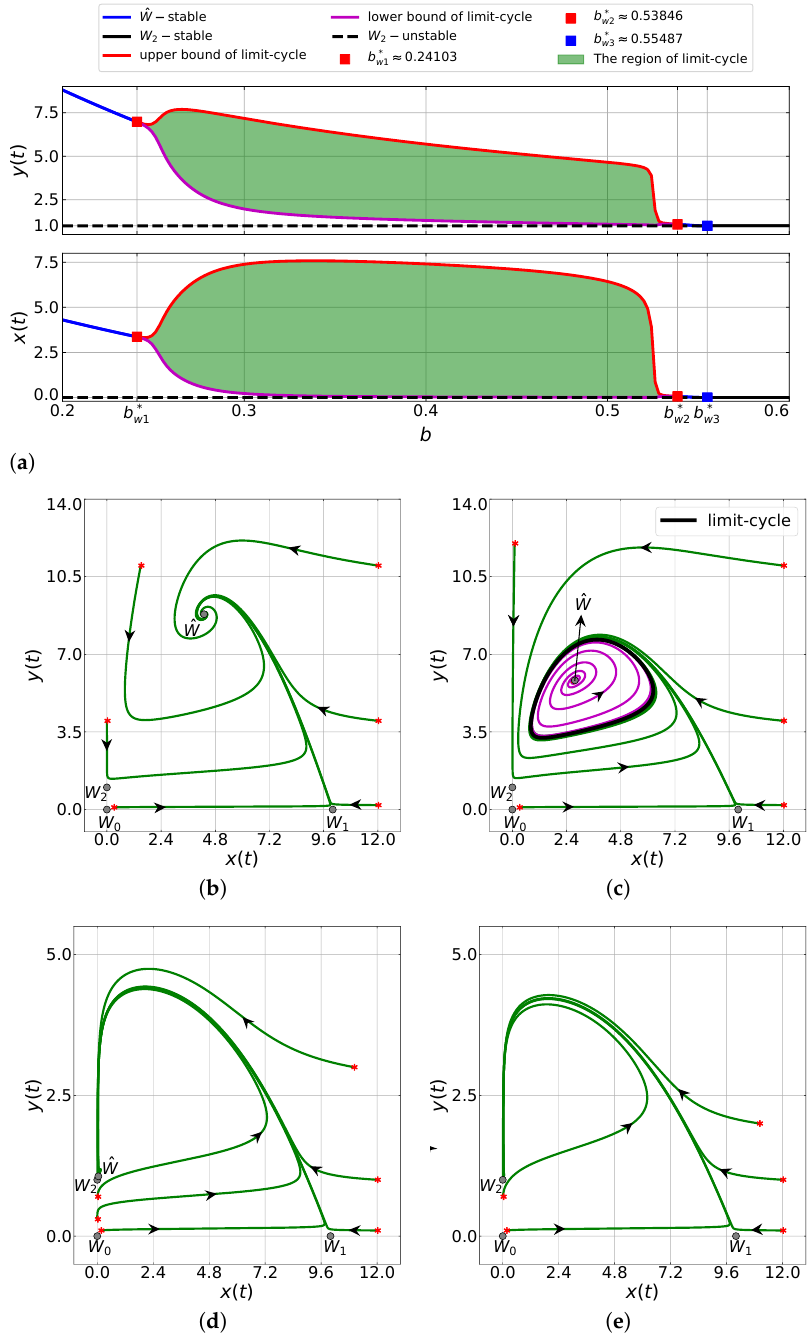
Figure 1. Dynamics of system (6) with parameter values (26) and α = 0.98. ( a ) Bifurcation diagram of system (6) driven by b for the case of the weak Allee effect ( m = − 1 < 0 ) . ( b – e ) Phase-portrait of system (6) with ( b ) b = 0.20, ( c ) b = 0.27, ( d ) b = 0.54, and ( e ) b = 0.57. The predator extinction point is always